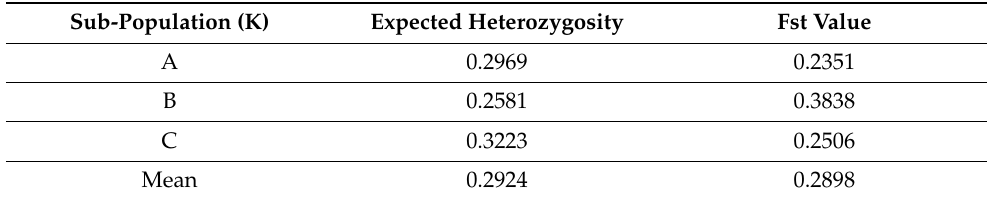
Table 6. Heterozygosity and Fst values of forage pea ( P. sativum ssp. arvense L.) landrace accession sub-populations.